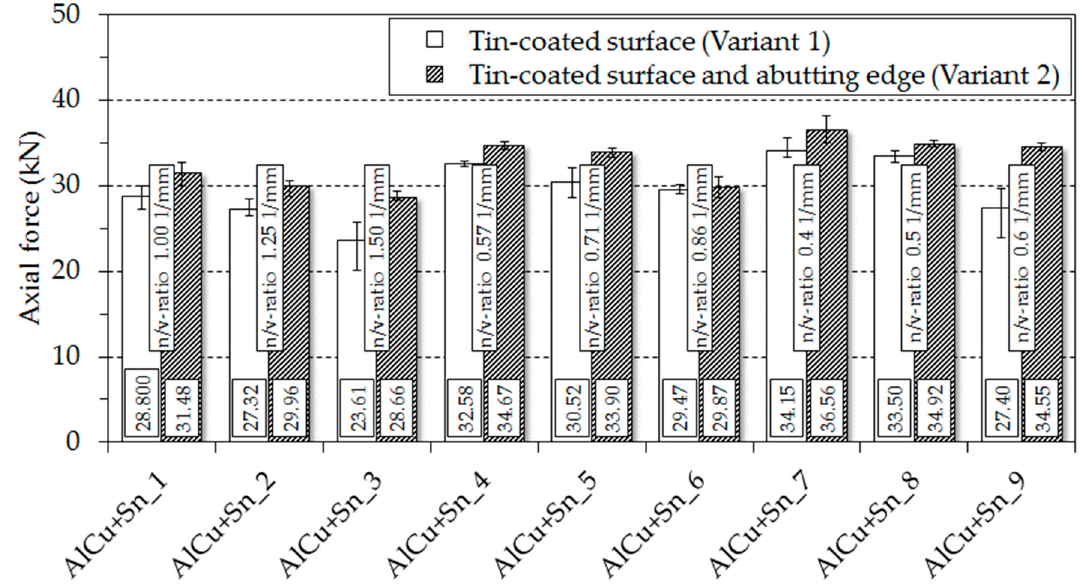
Figure 8. Average axial forces for the friction stir welding experiments performed using aluminum and tinned copper blanks.